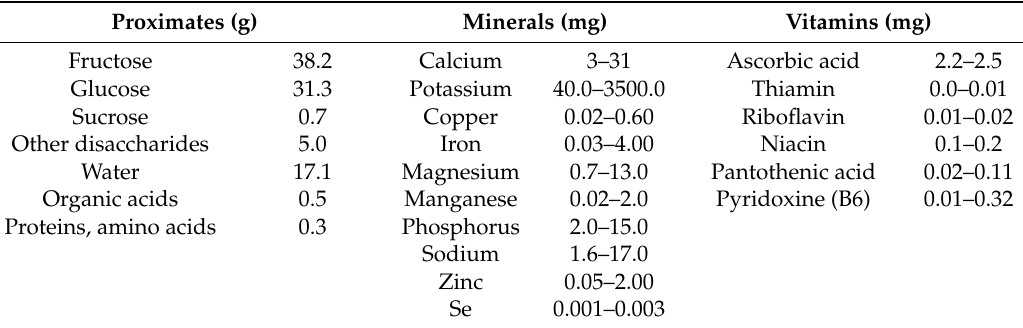
Table 1. Chemical composition of honey per 100 g